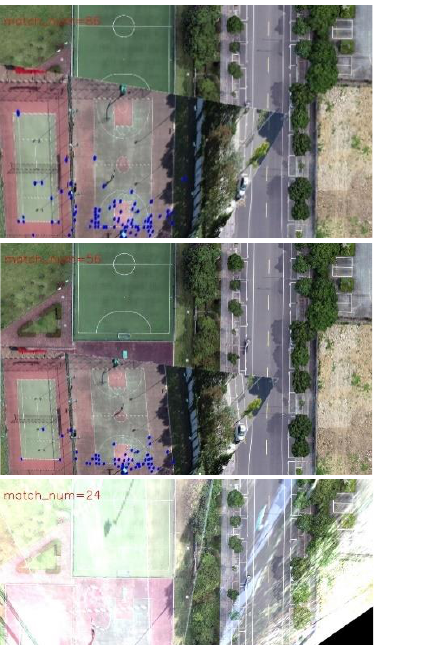
J. Imaging 2023 , 9 , 67 Figure 18. Registration difference image (after updating the map features). Figure 18. Registration difference image (after updating the map features).